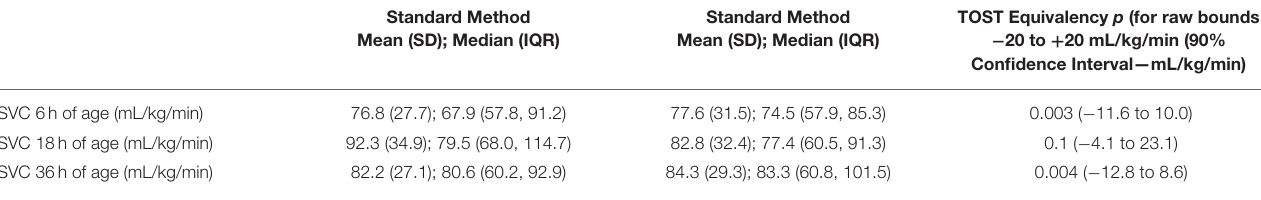
TABLE 2 | Superior Vena Cava (SVC) flow at three different time points and TOST (two-one-sided t -tests) equivalency test (raw bounds − 20 to + 20 mL/kg/min).